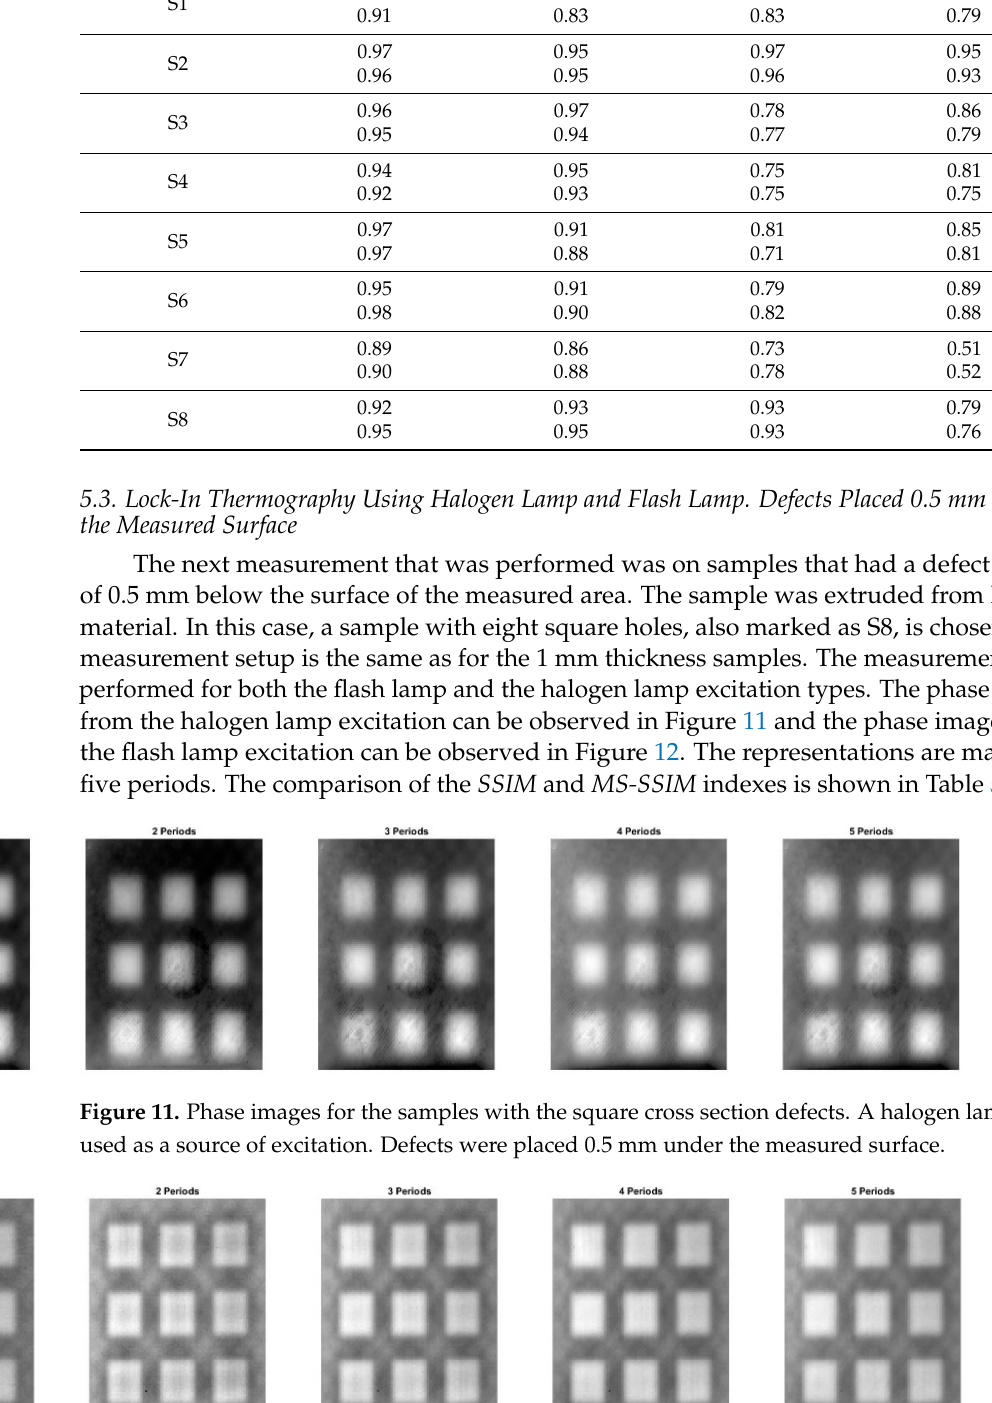
Table 4. Comparation of phase images for all measurement in the case of halogen lamp as source of excitation.